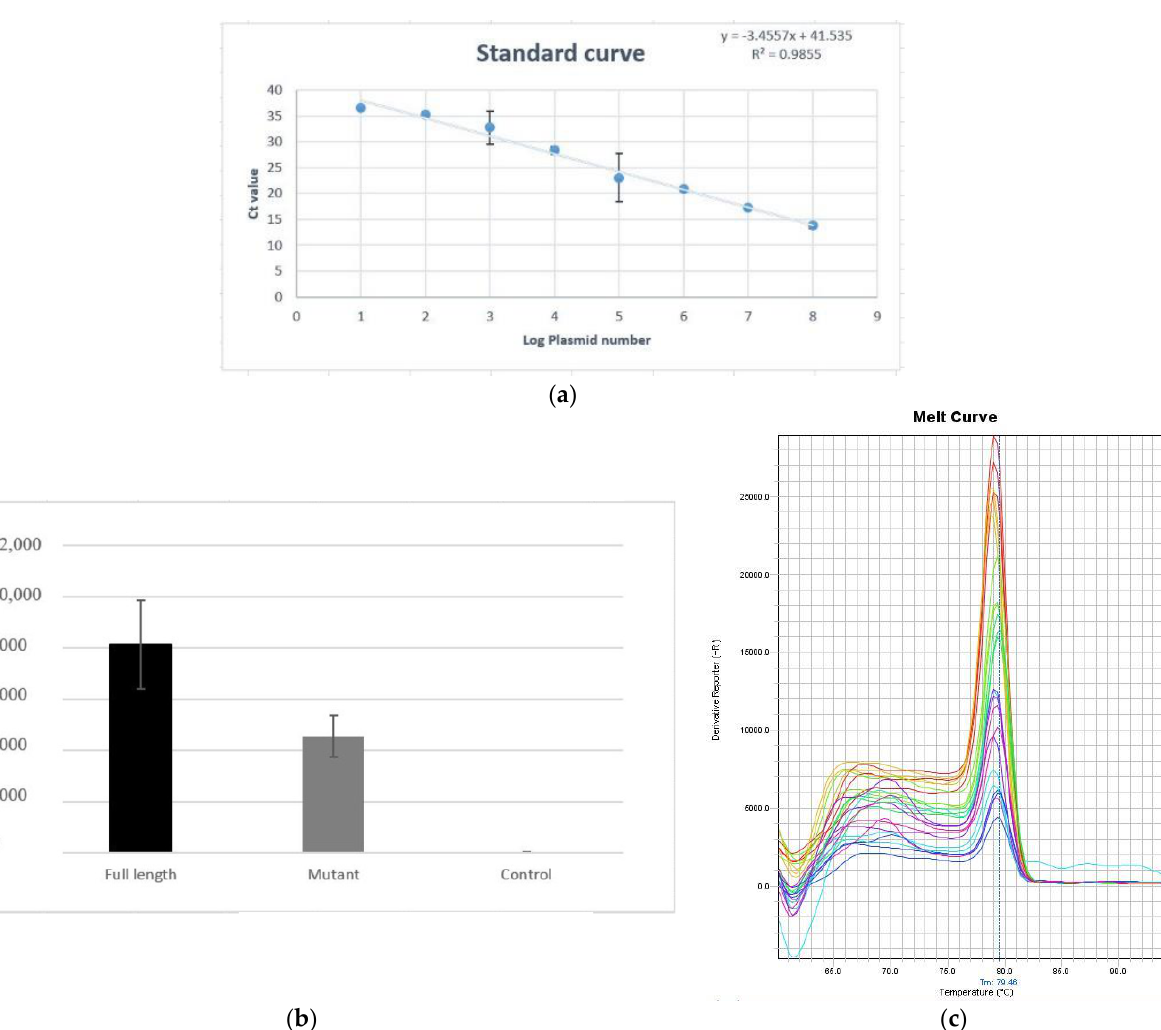
Figure 5. Quantitative real-time PCR (qPCR) data obtained from viral RNA as a template, indicating ( a ) Standard curve generated from the data obtained with R 2 of 0.9855. ( b ) Bar diagram indicating the RNA copy number per µg of RNA from the strains with full-length 3′ UTR, deletion mutant, and the negative control. ( c ) The melt curve.